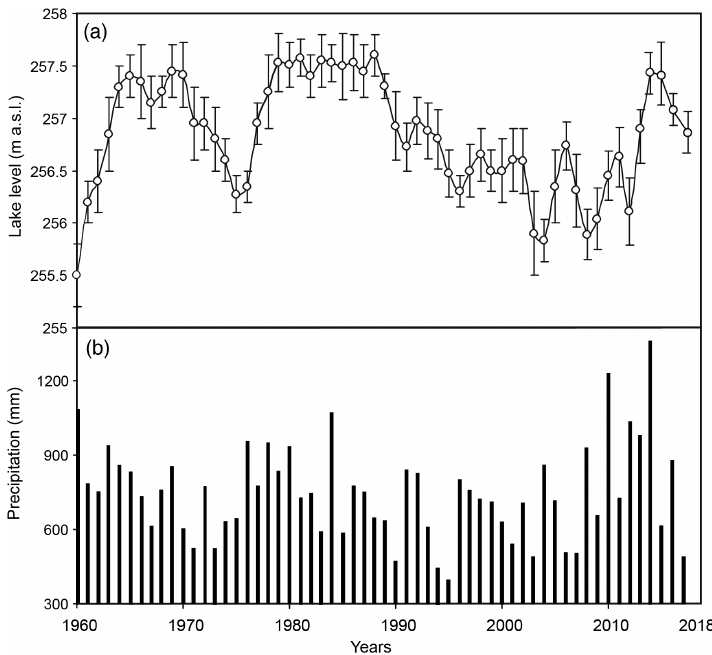
Figure 3 . ( a ) Annual average, maximum, and minimum levels of Lake Trasimeno and ( b ) annual precipitations from 1960 to 2017; 1960–2003 data are taken from [5] and [6]; 2004–2017 data are taken from www.clubvelicotrasimeno.it [34].